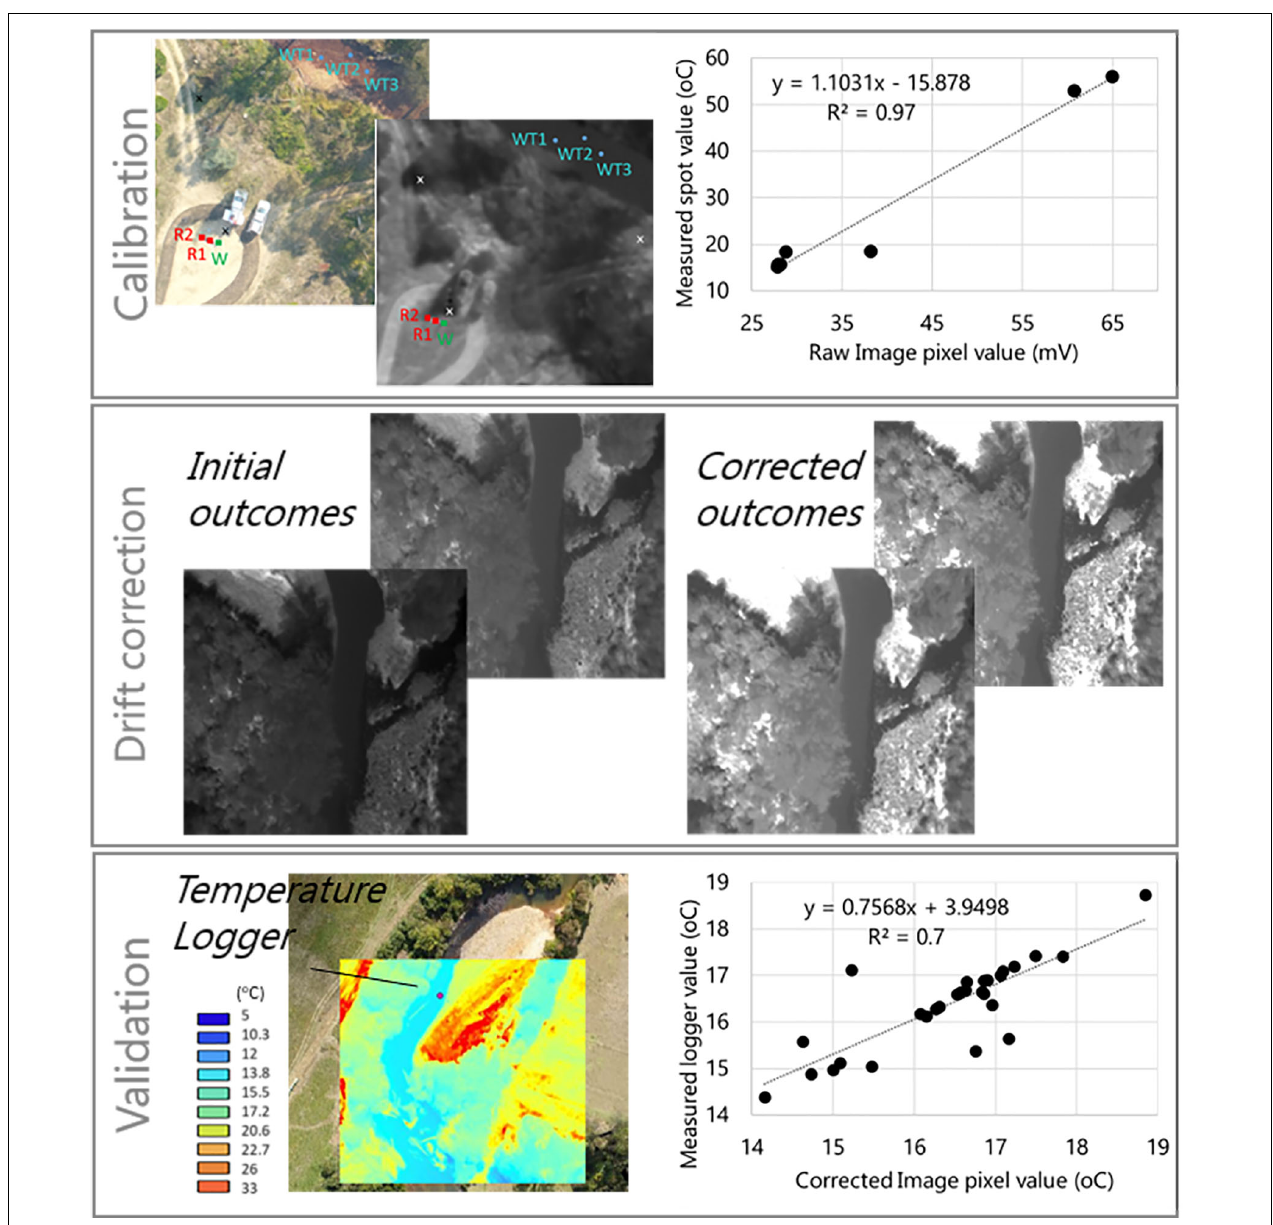
FIGURE 3 | Illustration of the ground thermal calibration targets used in one of the flights as an input to the linear model for TIR imagery thermal calibration (top), outputs of the thermal drift correction (middle), and example of one of the temperature logger location (bottom, left) used as one of the inputs for the final thermal validation (bottom,